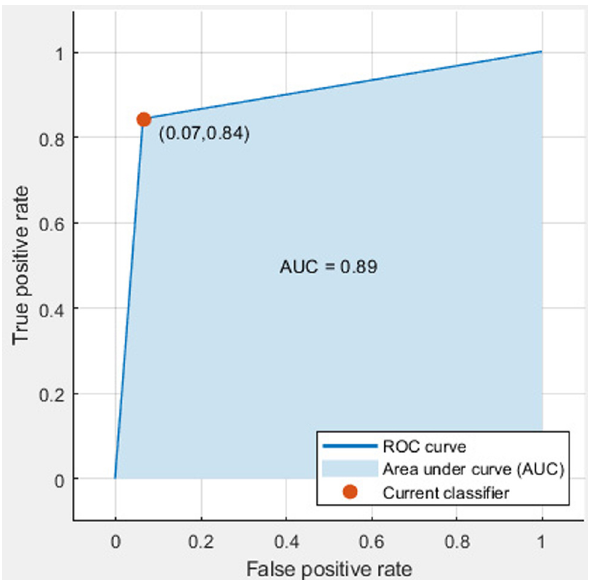
Figure 5: ROC curves for LightGBM